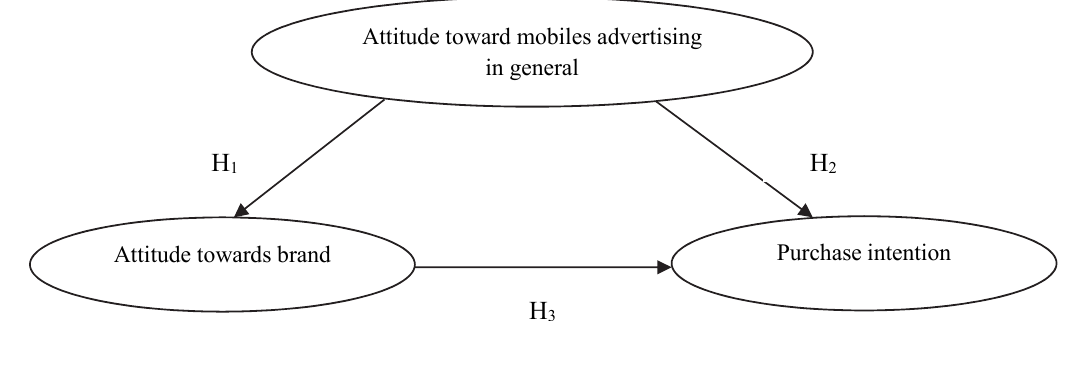
Fig. 1. The conceptual